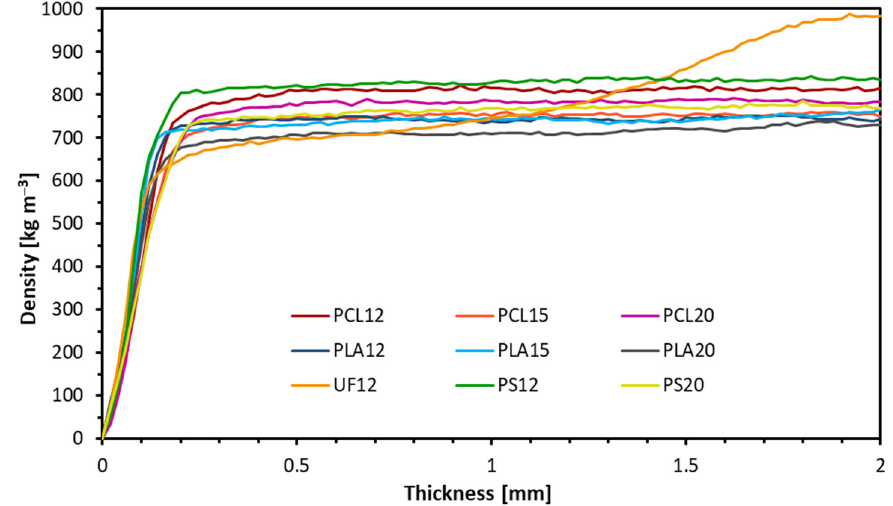
Figure 2. Density profiles of manufactured lignocellulosic composites.